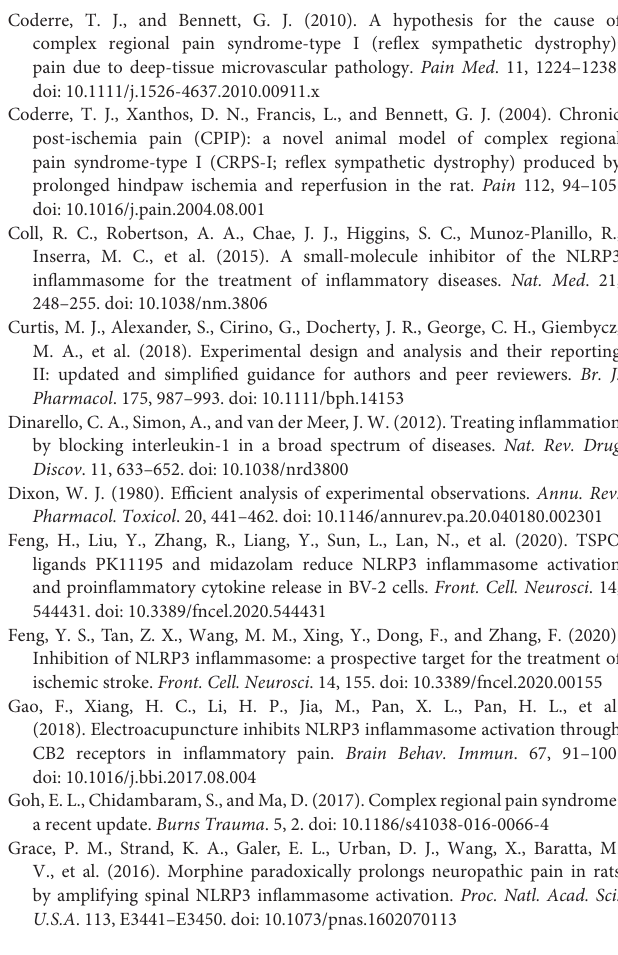
FIGURE 9 | from panel B. ** p < 0.01 vs. Sham group. ## p < 0.01 vs. CPIP + Veh group. (D) Immunostaining of GFAP in ipsilateral SCDH after intrathecal IL-1Ra/Vehicle injection. (E) Summary of mean fluorescence intensity of GFAP (normalized to CPIP + Veh group). (F) Summary of total number of GFAP + cells/observation field. (G) Immunostaining of OX42 in ipsilateral SCDH after intrathecal IL-1Ra/Veh injection. (H) Summary of mean fluorescence intensity of OX42 (normalized to CPIP + Veh group). (I) Summary of total number of OX42 + cells/observation field. * p < 0.05, ** p < 0.01 vs. CPIP + Veh group. n = 5 rats/group. Scale bar indicates 100 µ m. Two-way ANOVA with Tukey’s post-hoc test was applied in panel B. Student’s t test was used in other